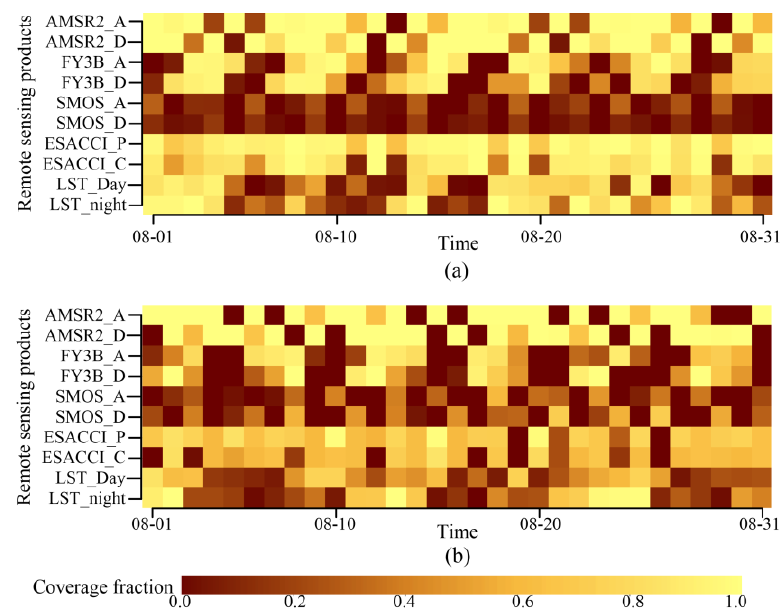
Figure 3. Daily coverage fractions of remote sensing products (i.e., eight groups of four coarse SSM products and MODIS LST) during August 2012 in two experimental regions: ( a ) upper HBR area and ( b ) Naqu area.